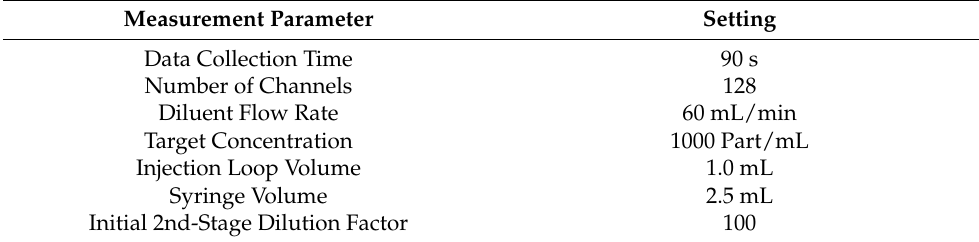
Table 3. Measurement parameters on the AccuSizer 780 APS